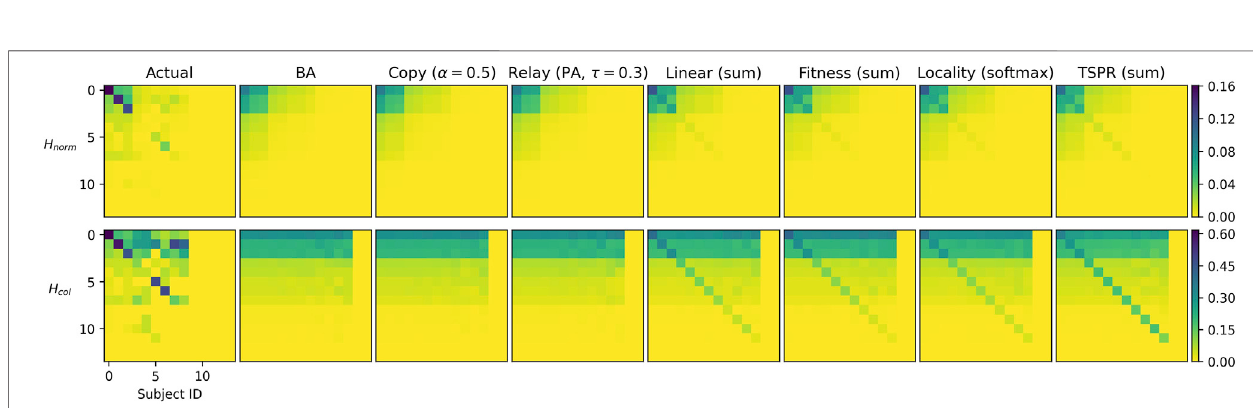
Frontiers in Physics |